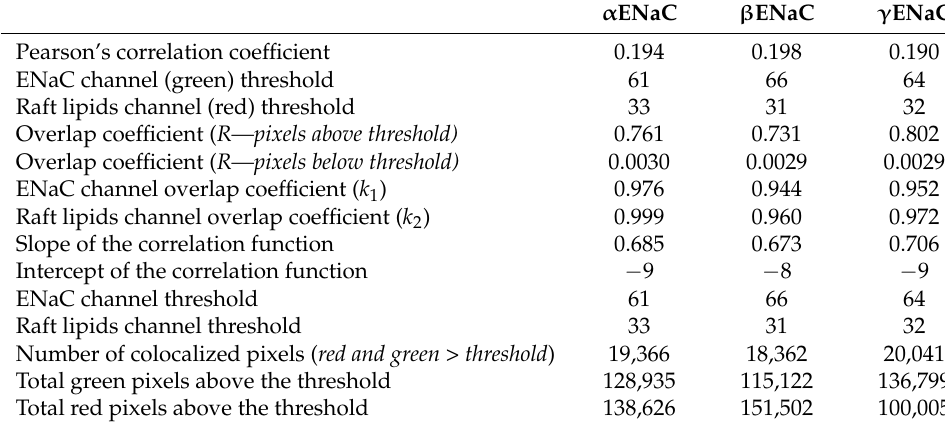
Table 1. Co-localization parameters for ENaC and raft lipids.